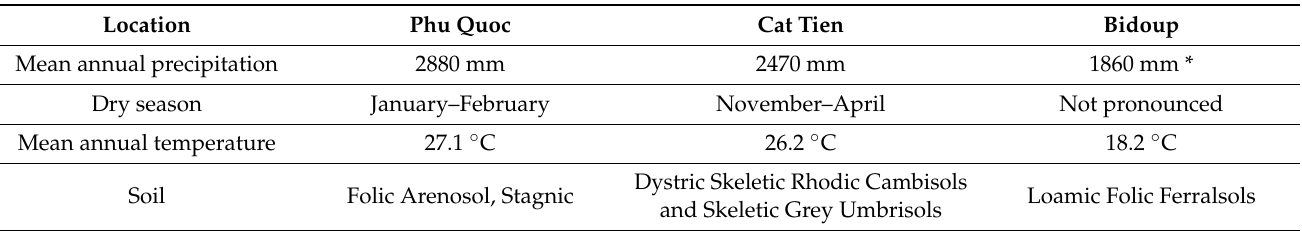
Figure 1. Map of the study region. Sample sites are marked with red circles. Table 1. Edaphic and climatic conditions of the habitats